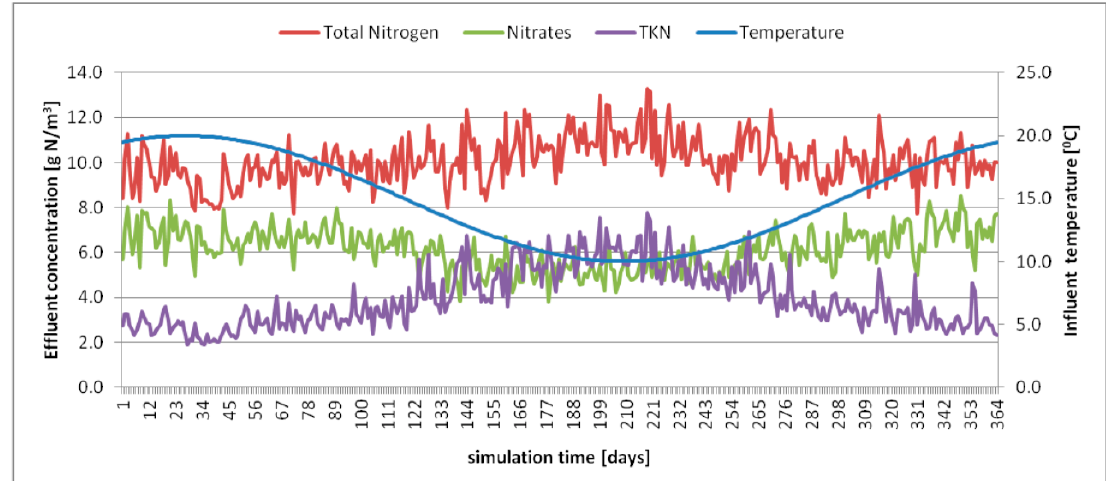
Figure 3. Time series of simulated values of total nitrogen, nitrates and total Kjeldahl nitrogen (TKN) in the effluent versus influent temperatures, Scenario 1 (S1). Day 1 represents 1st of July.